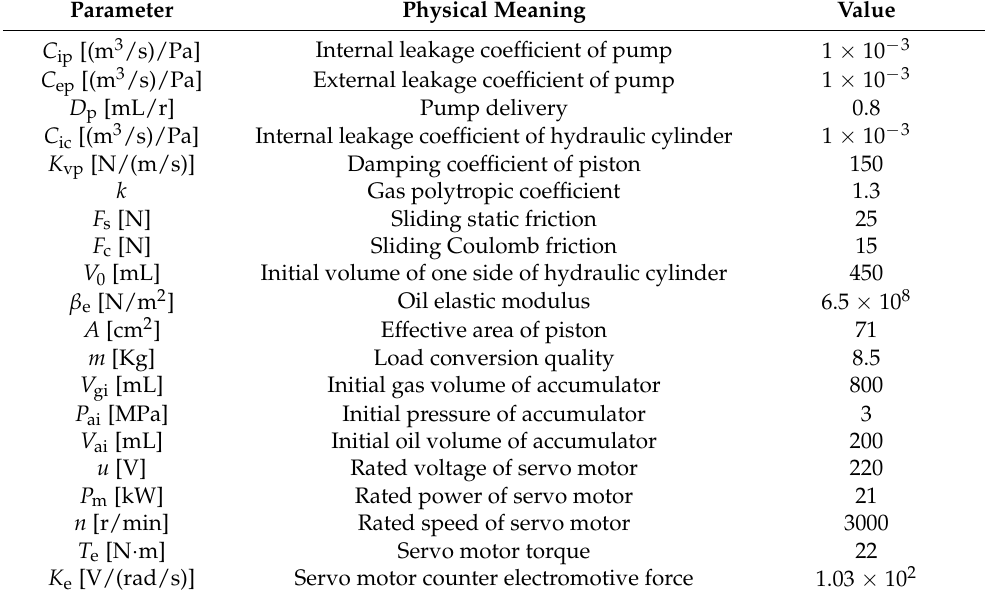
Table 3. System simulation model parameters.